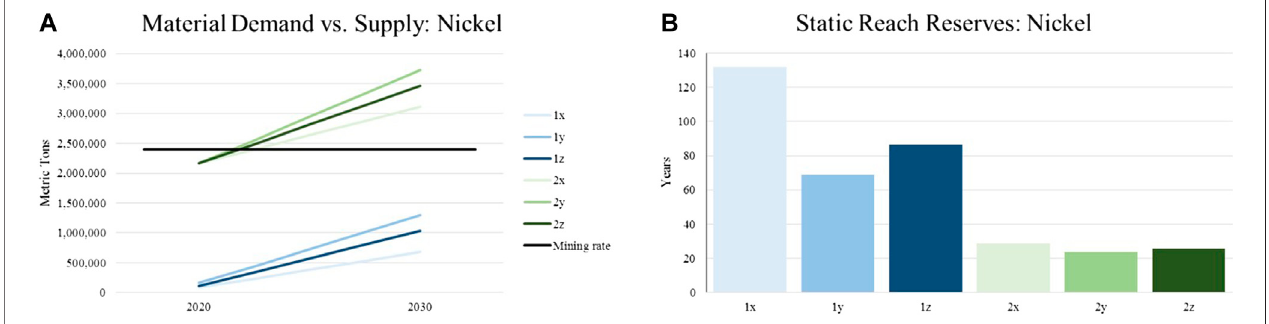
FIGURE 4 | Analysis of nickel raw material